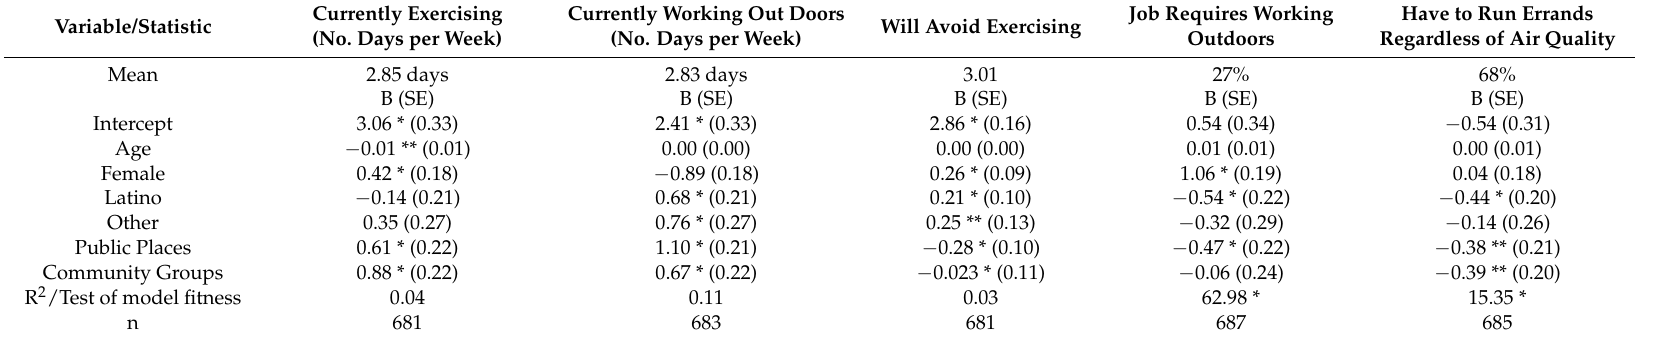
Table 5. Avoiding exercise, working outdoors, or running errands when air quality is “bad” or “unhealthy”.